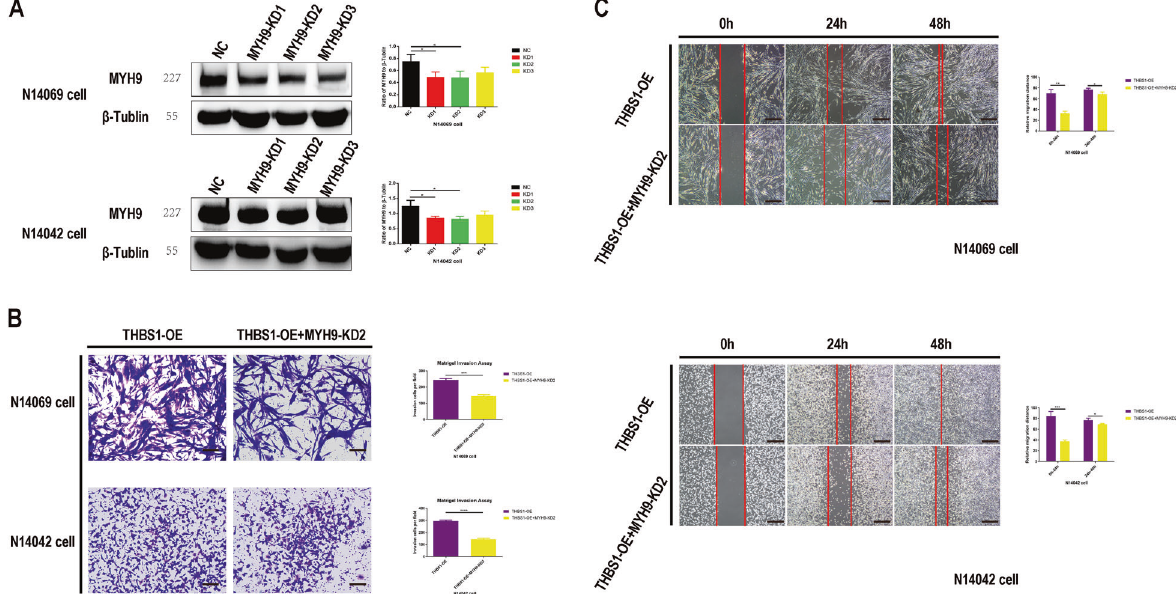
Fig. 7 Myosin heavy chain 9 (MYH9) knockdown inhibits glioma cell invasion and migration in cells that overexpress thrombospondin 1 (THBS1). A Western blot images and corresponding histograms of MYH9 protein in glioma cells transient transfected with three MYH9 short hairpin RNA (shMYH9): KD1, KD2, and KD3. Representative images and corresponding histograms of B Transwell migration (×100 magni fi cation) and C scratch assay results (×40 magni fi cation) showing the migration and invasion of glioma cells, respectively. Compared with THBS1-OE only, in cells that overexpress THBS1 and were transiently transfected with shMYH9, the glioma cells showed inhibited migration and invasion. Data are shown as mean ± standard deviation (SD), n = 3, * p < 0.05, ** p < 0.01, *** p < 0.001, **** p < 0.0001, Student ’ s t novel strategy for the treatment of recurrent gliomas that involves targeting the THBS1/MYH9 axis. THBS1 is a member of the multidomain and multi-functional the function of the MYH9 protein. MYH9 knockdown experiments calcium-binding extracellular glycoprotein family. The family con fi rmed the association between MYH9 and glioma progression. consists of fi ve protein-coding genes: THBS1 , thrombospondin 2 These fi ndings provide new insights for the use of apatinib in (TSP-2), TSP-3, TSP-4, and TSP-5 (ref. [33]). THBS1 was initially postoperative chemotherapy of recurrent gliomas and present a